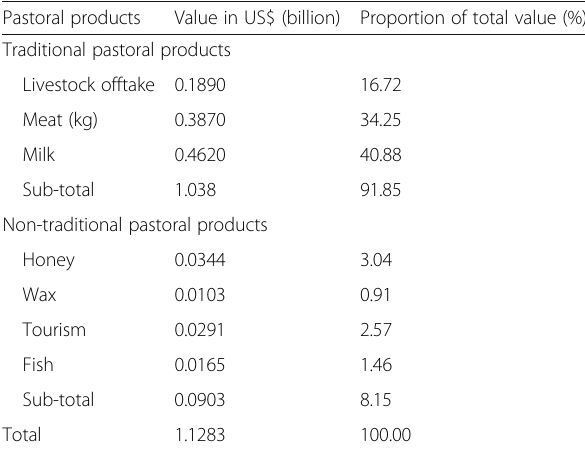
Table 10 Overall computed total economic value of pastoralism in Kenya (US$) billion Pastoral products Traditional pastoral